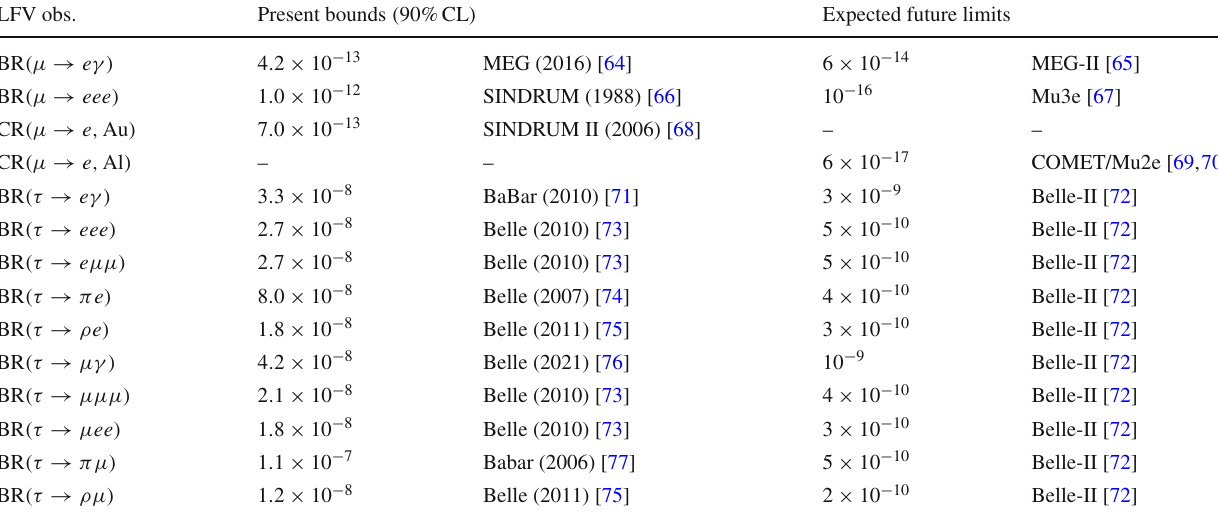
Table 3 Present upper bounds and future expected sensitivities for the set of low-energy LFV transitions relevant for our analysis LFV